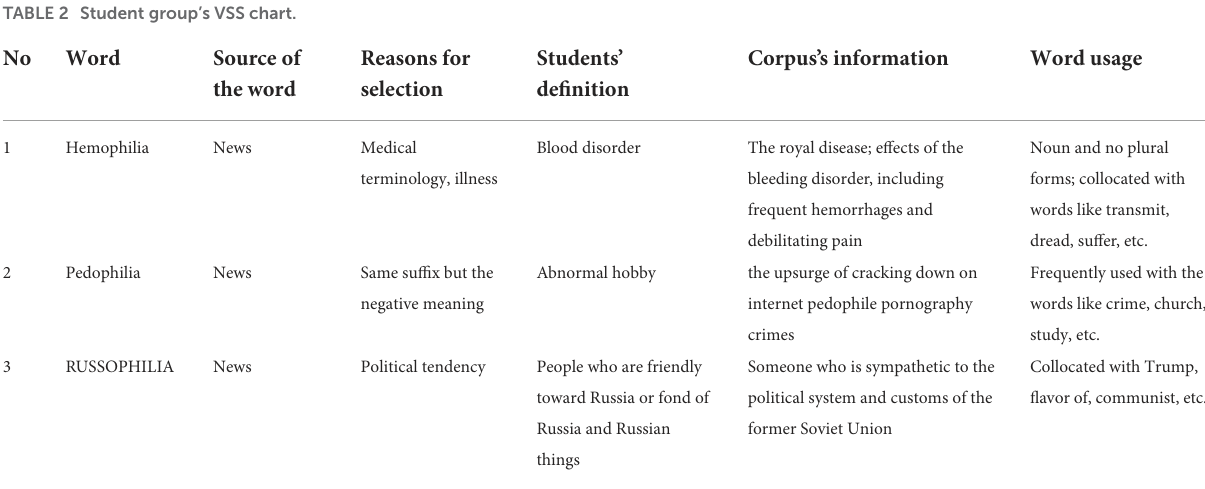
TABLE 2 Student group’s VSS